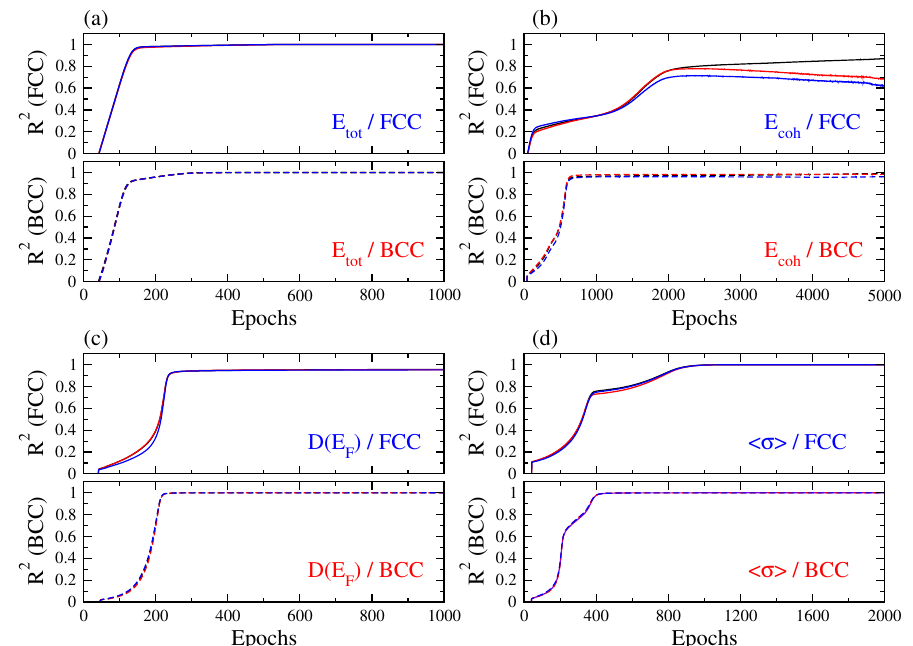
Figure 4. The accuracies of the ANN models, measured by R 2 , during training (black), validation (red) and test (blue), for: ( a ) E tot , ( b ) E coh , ( c ) D ( E F ) and ( d ) (cid:104) σ (cid:105) . The data are presented for FCC (solid) and BCC (dashed) structural configurations.